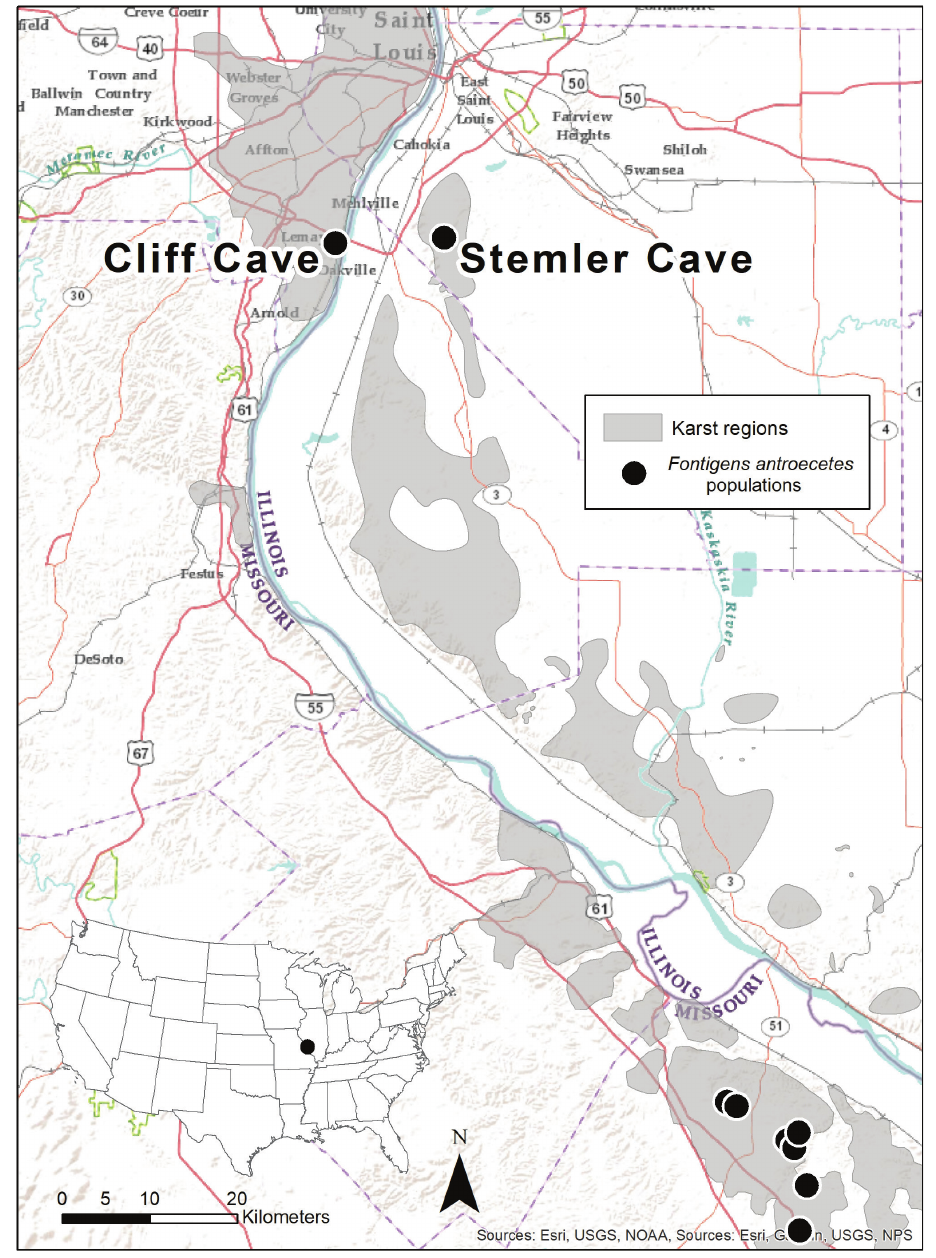
Figure 1. Distribution of the Enigmatic Cavesnail ( Fontigens antroecetes ). Gray areas represent karst regions. Black dots represent known